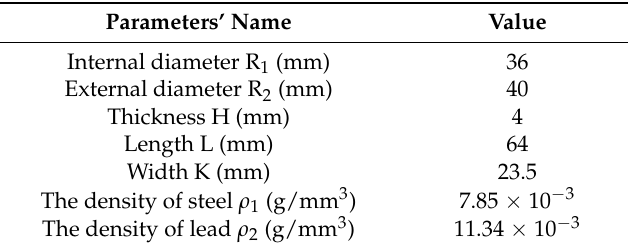
Table 2. Parameters related to stable platform.